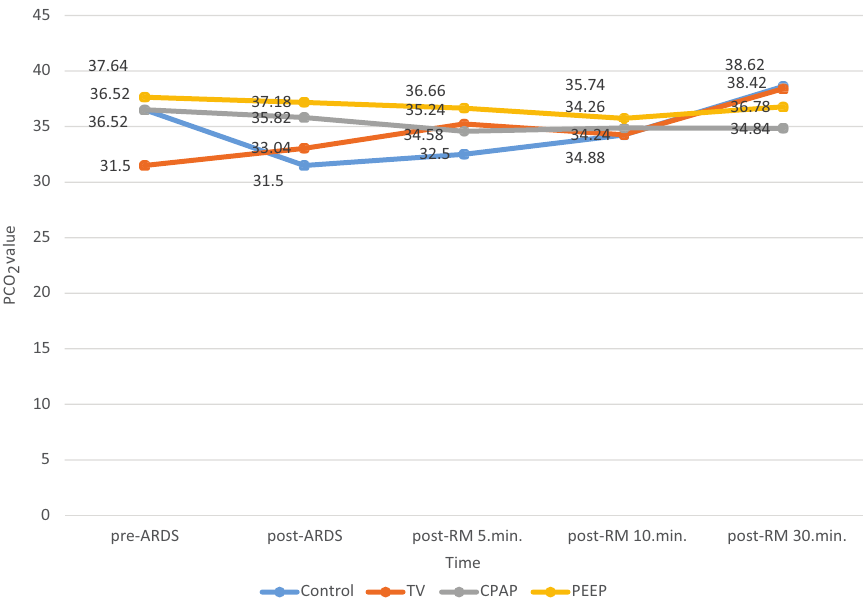
Figure 3. Change of the PaCO values. PaCO , partial arterial carbon dioxide pressure; ARDS, acute 2 2 respiratory distress syndrome; TV, tidal volume; CPAP, continuous positive airway pressure; PEEP, positive end-expiratory pressure; RM, recruitment maneuver.